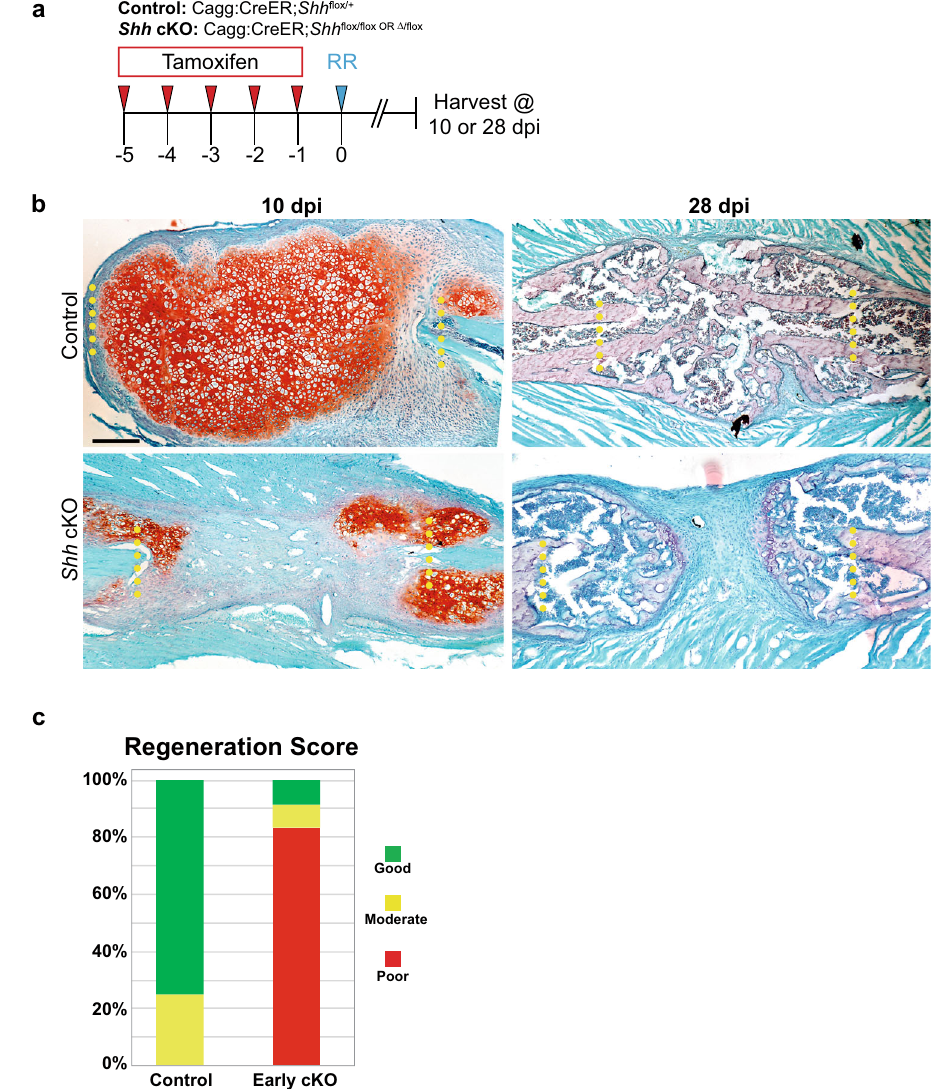
Fig. 2 Shh is required for callus generation and subsequent large-scale rib regeneration. a Experimental overview. To evaluate knock out of Shh globally, Cagg:CreER; Shh fl ox/ + controls and Cagg:CreER ;Shh fl ox/ fl ox or Cagg:CreER ;Shh Δ / fl ox experimental animals ( Shh cKO) received tamoxifen injections on days − 5, − 4, − 3, − 2, and − 1. Resections were performed on day 0 and tissue was harvested at 10 or 28 dpi to assess regeneration outcomes. b Safranin-O stained histological sections at 10 and 28 dpi. At 10 dpi, control animals generate calluses mainly composed of cells with chondrocyte morphology, whereas a large callus does not form in Shh cKO mice. Only small amounts of Safranin-O stained cartilage can be seen adjacent to the cut sites. At 28 dpi, controls have successfully converted the large cartilage callus to bone that fully spans the defect site. Global Shh cKO mice are similarly able to convert cartilaginous regions adjacent to the cut sites to bone, however the central portion of the callus remains undifferentiated and the injury site remains unbridged resulting in a non-union. Scale bar = 200 microns. c Blinded scoring of regeneration outcomes. Safranin-O stained sections were used to score regeneration outcomes as Good, Moderate, or Poor (see Methods for details regarding scoring criteria). Overall, controls largely heal well (6/8 animals), whereas Shh cKO animals largely heal poorly (10/12 animals). Animals from 10 and 28 dpi were pooled together for graphical